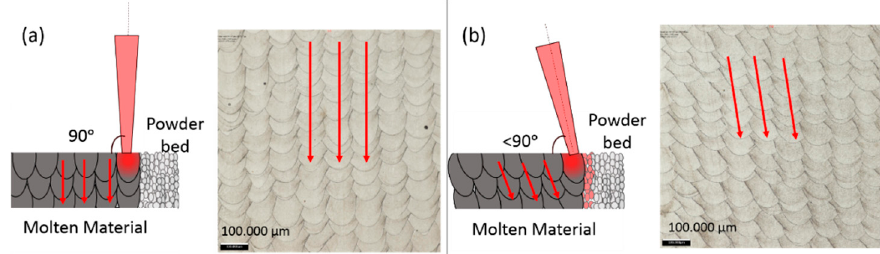
Figure 7. Analysis of the microstructure in the different parts located at 45°: ( a ) central part (radial distance from the center 20 mm); ( b ) Part located at the edge of the platform (radial distance from the center 145 mm).